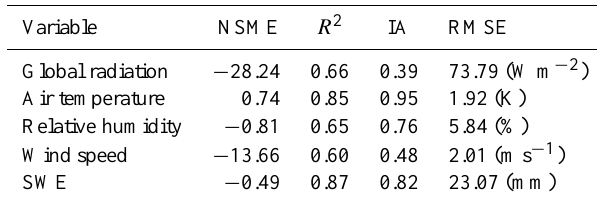
Table 2. Predictive capabilities of outside-canopy observations for inside-canopy